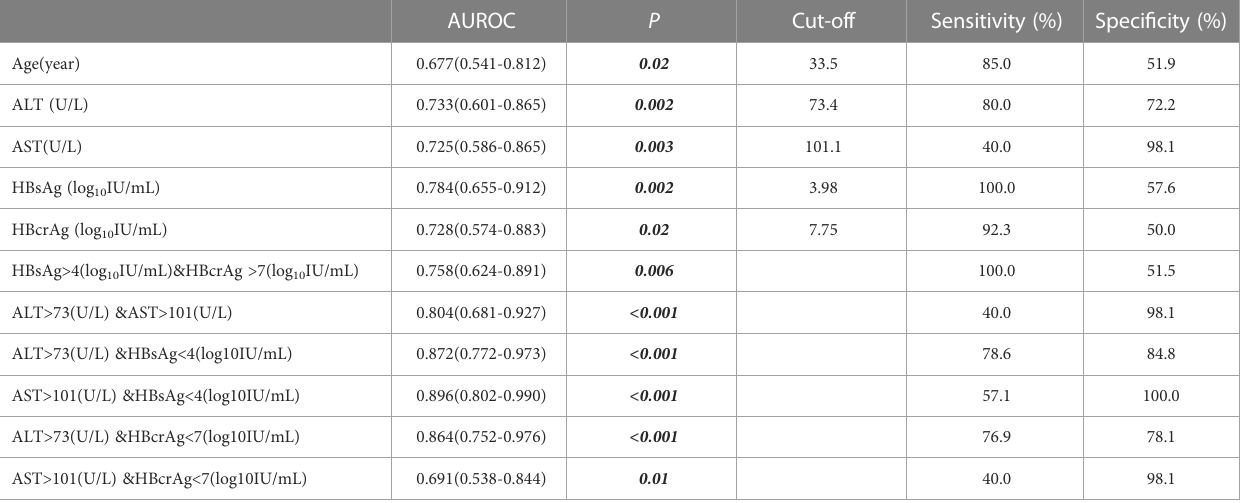
TABLE 3 Performance of variables to diagnose signi fi cant in fl ammation (G ≥ 3 according to the Scheuer scoring system) in HBeAg-positive patients at baseline. AUROC